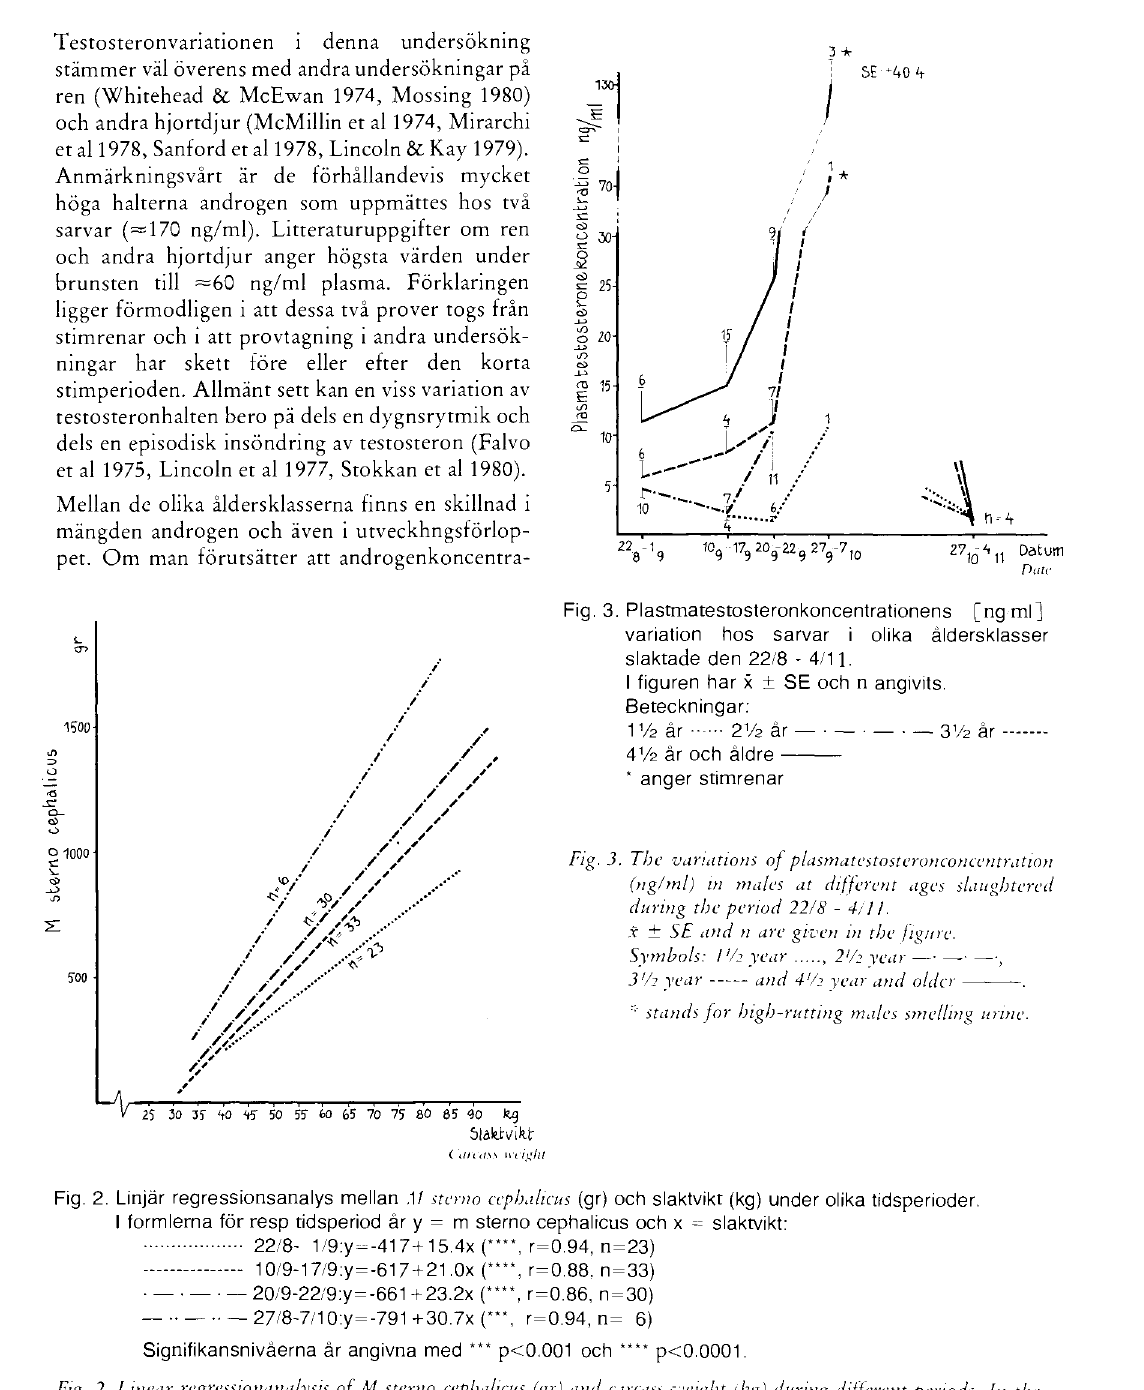
Fig. 2. Linear regressionanalysis of M steruo cephalieus (gr) and carcass weight (kg) during different periods. In the equations are y=M stemo cephalieus and x = carcass weight. The levels of significant: p<0.001 and